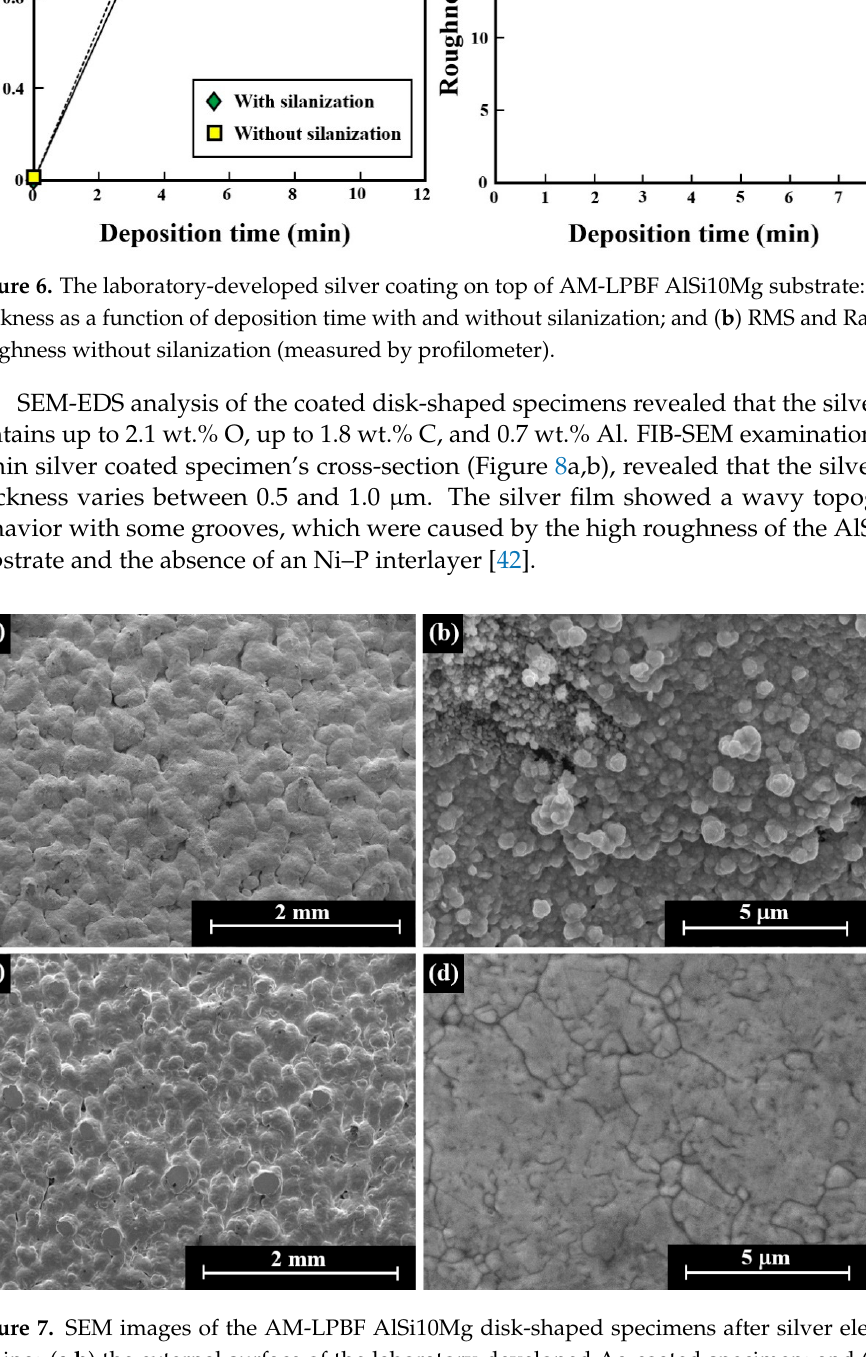
Figure 7. SEM images of the AM-LPBF AlSi10Mg disk-shaped specimens after silver electroless plating: ( a , b ) the external surface of the laboratory-developed Ag coated specimen; and ( c , d ) the external surface of the commercial Ag coated specimen.